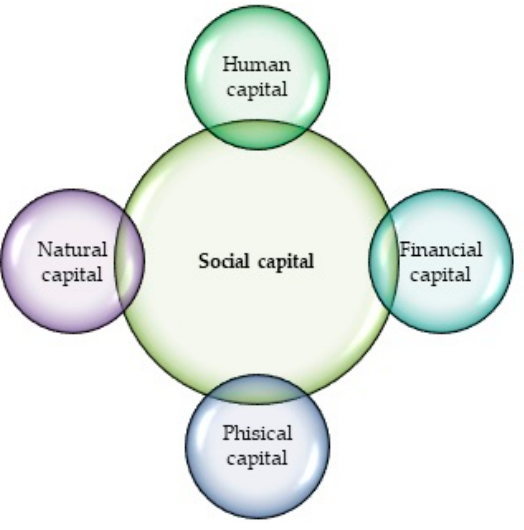
Figure 2. Balance of five forms of capital. Source: adapted from Soulard et al. (2018) [32]. Table 5. Role of social capital in various contexts of